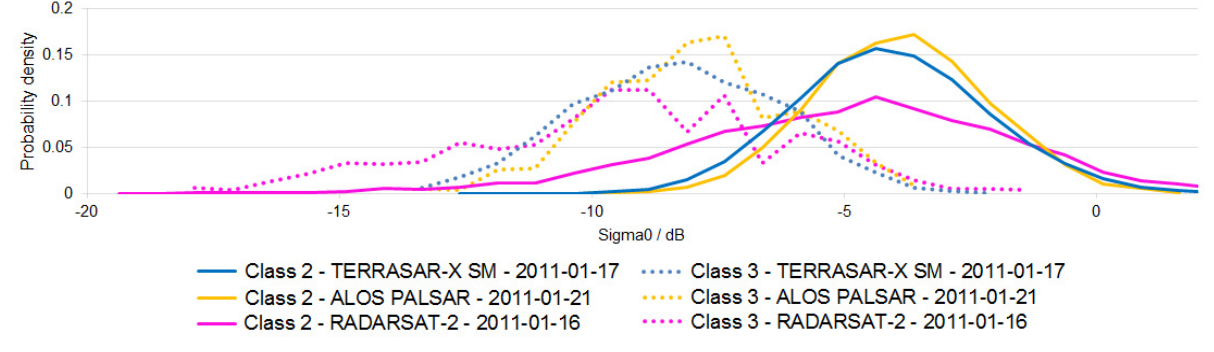
Figure 7. Histograms of class 2 and 3: TerraSAR-X SM (17 January 2011), ALOS PALSAR (21 January 2011), and RADARSAT-2 (16 January 2011).